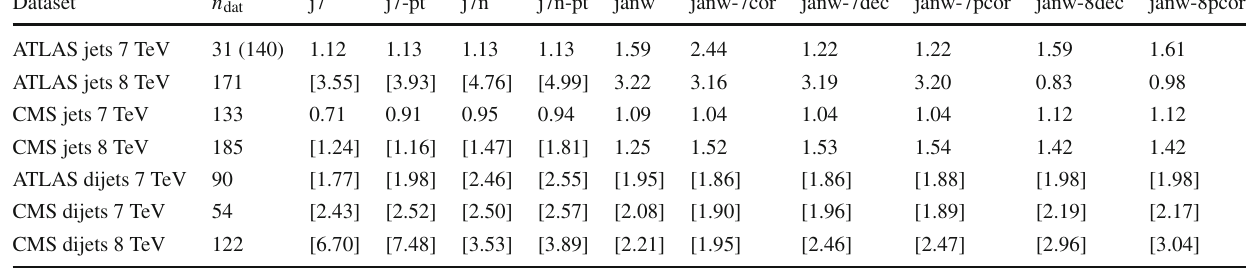
erence. Note that for the fits with alternative decorrelation models for the ATLAS 7 TeV data (#janw-7cor, #janw-7dec and #janw-7pcor) the